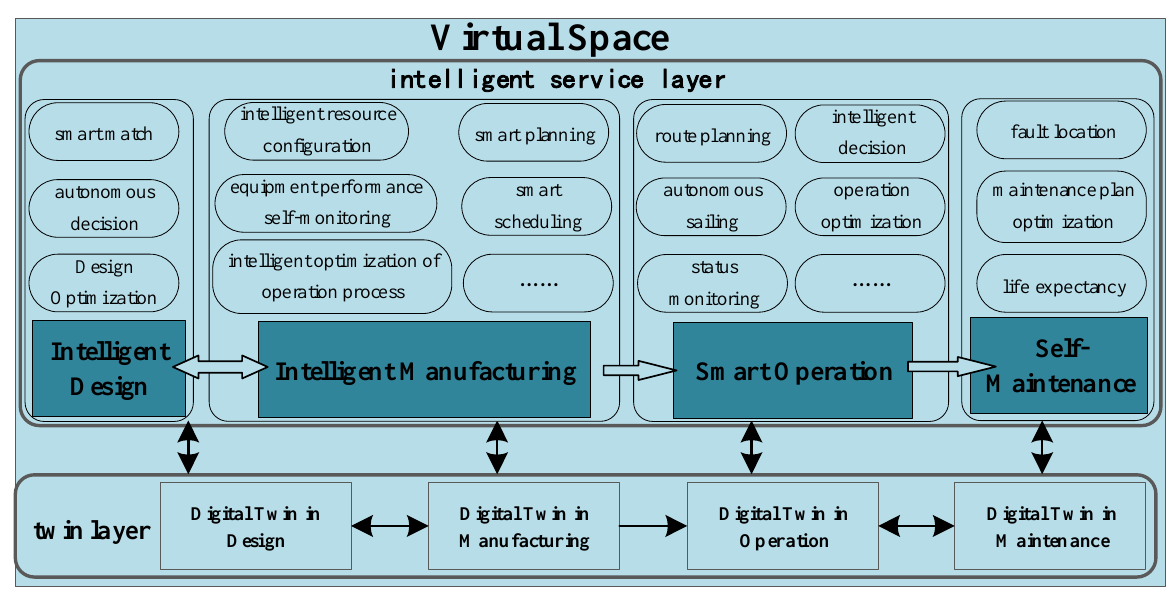
Figure 3. The structure of the virtual space.